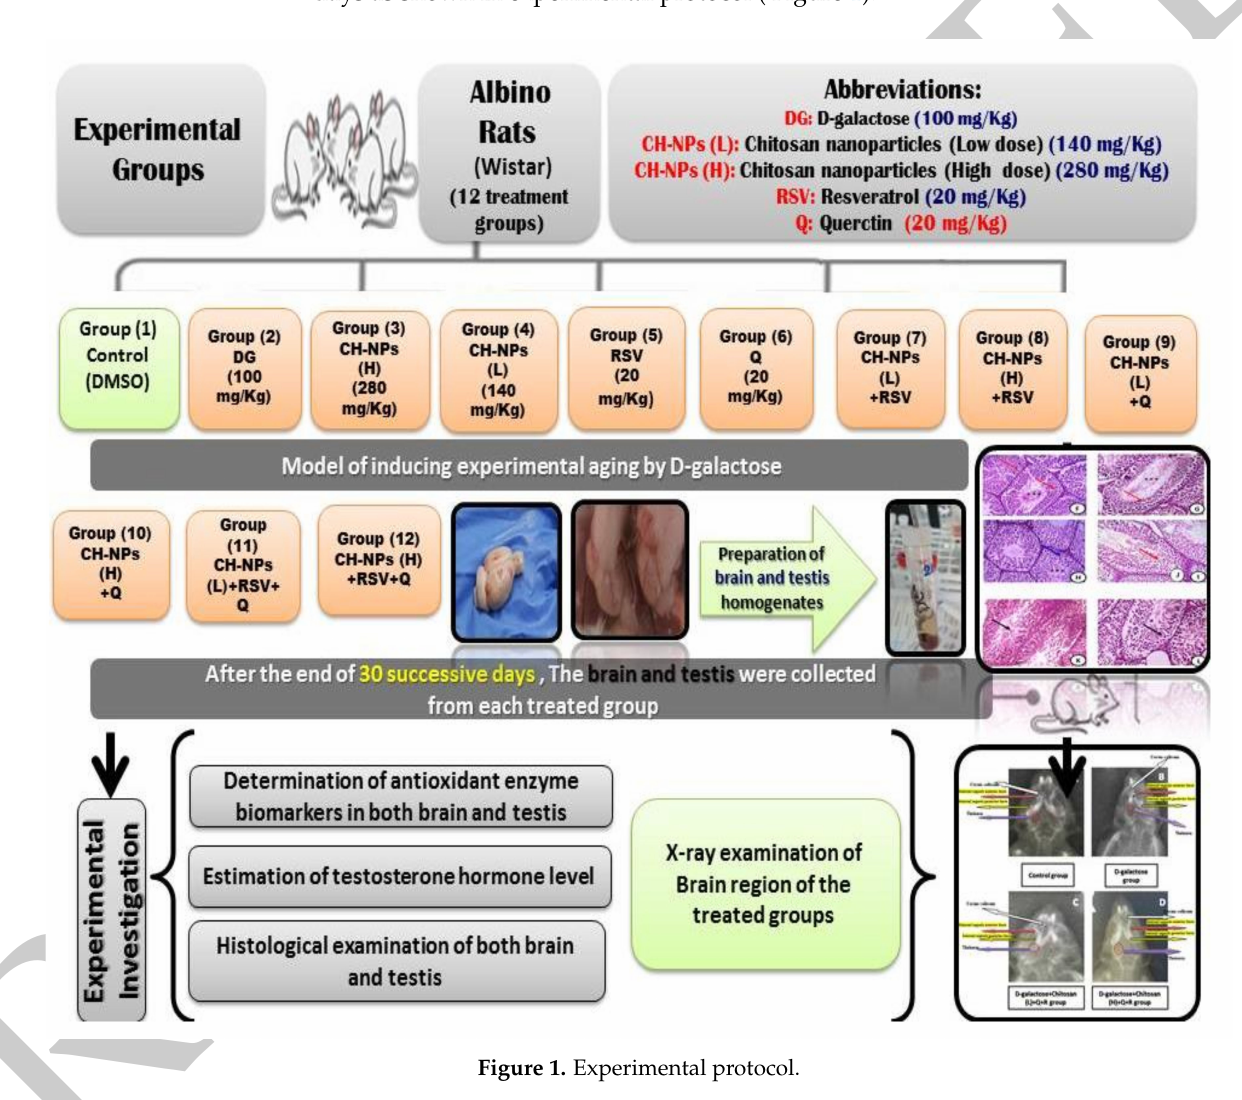
Figure 1. Experimental